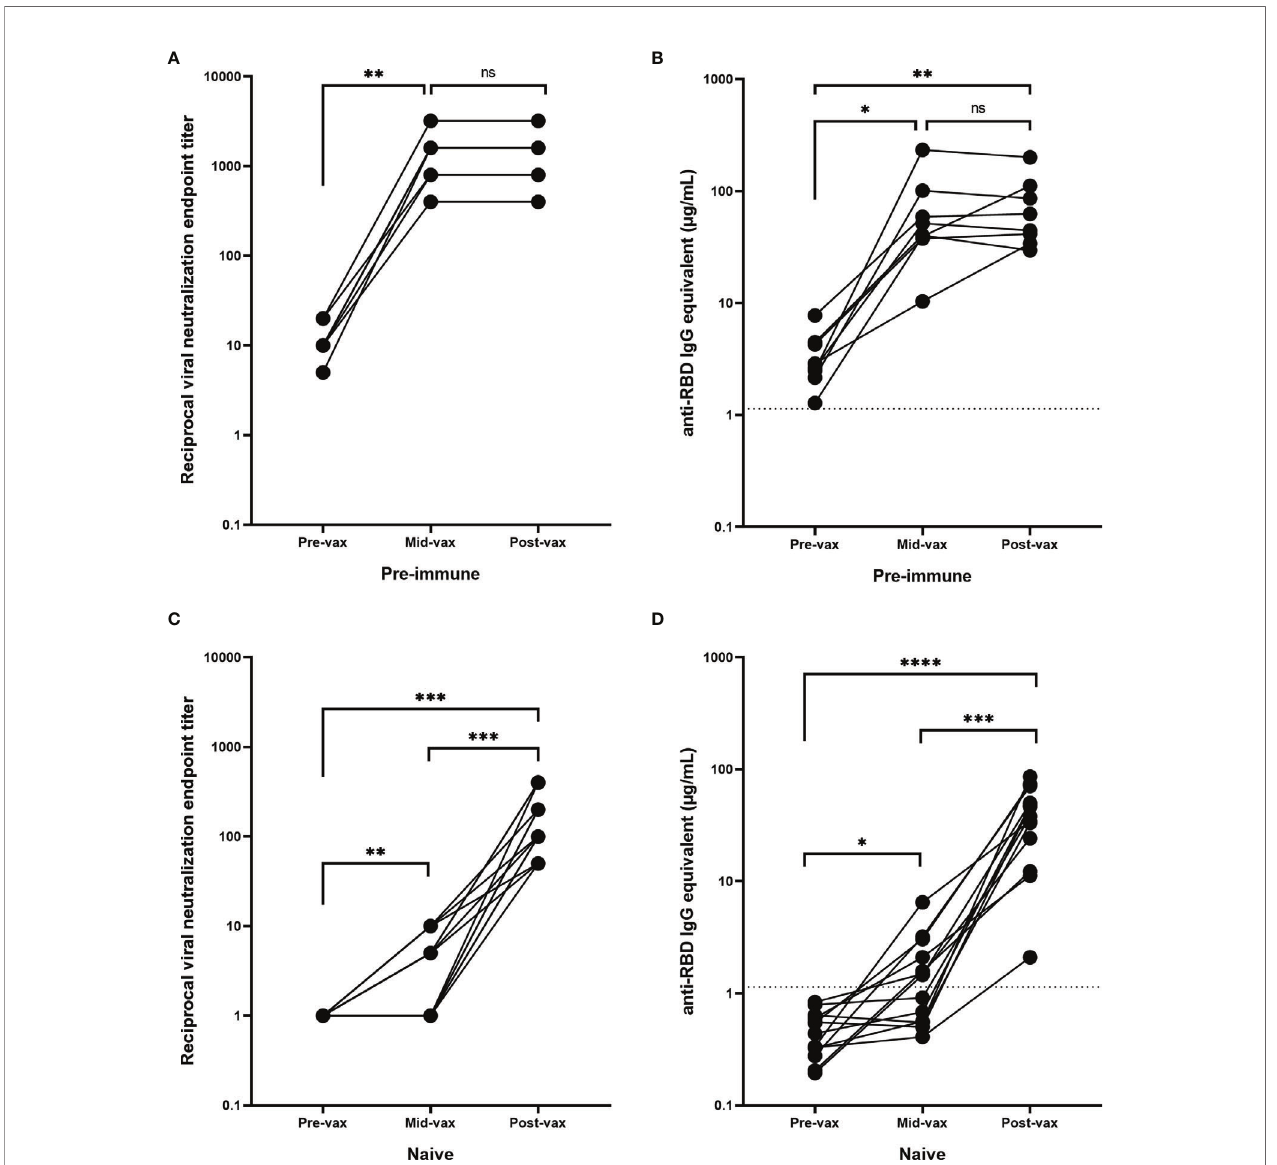
FIGURE 4 | Antibody response during vaccination. Pre-immune participants (n = 8) with serum obtained between the two mRNA vaccinations (mid-vax) have demonstrated a signi fi cant increase in (A) neutralizing (** p = 0.002) and (B) anti-RBD antibody levels (* p = 0.03) before the second vaccination was administered, and there was no signi fi cant change (ns) in antibody titer in response to the second vaccination ( p = 0.69). Immunologically naïve participants (n = 13) with serum obtained between the two mRNA vaccinations have demonstrated a signi fi cant increase in (C) neutralizing (*** p = 0.0005), and (D) binding antibody levels (**** p < 0.0001). Six of them showed no neutralizing activity before the second vaccination was administered. While the other 7 showed a signi fi cant increase (** p = 0.0074) and exhibited a low level of neutralization even after the fi rst vaccination, the second vaccination was still crucial in boosting antibody levels (*** p = 0.0006). In order to represent the values on a logarithmic scale, lack of neutralization was reported as